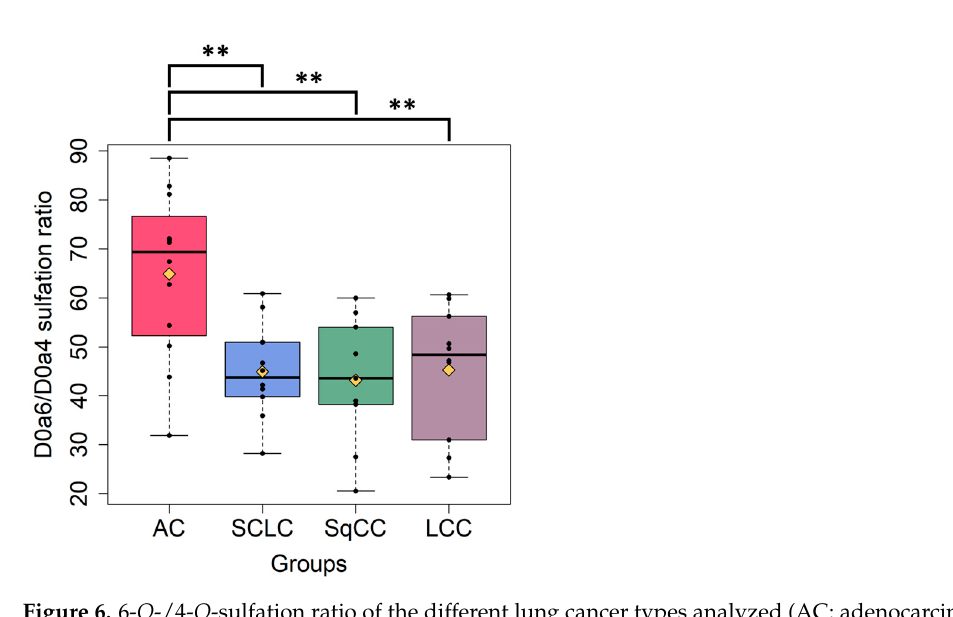
Figure 6. 6- O -/4- O -sulfation ratio of the different lung cancer types analyzed (AC: adenocarcinoma, SCLC: small cell lung cancer, SqCC: squamous cell carcinoma, LCC: large cell carcinoma). The yellow diamonds are the average values of the given sample groups. (**: p < 0.01).